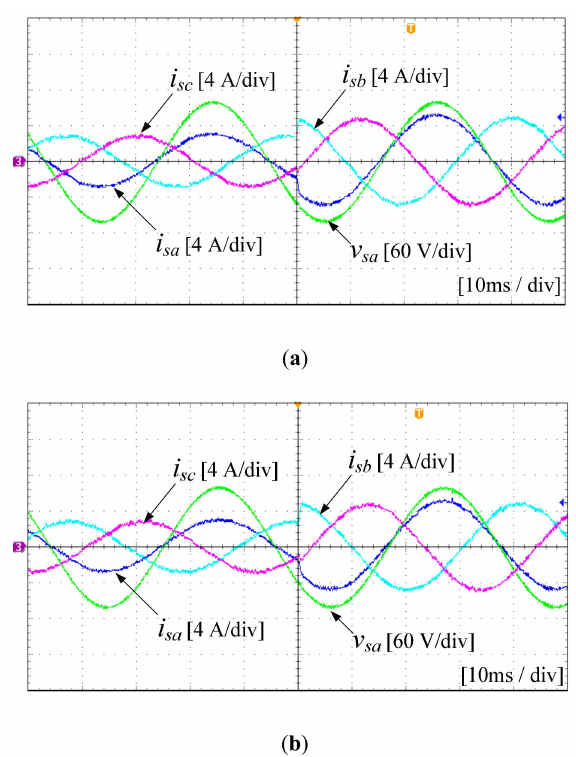
Figure 13. Experimental waveforms of the three-phase source currents and the a -phase source voltage for the source current magnitude step change from 3 A to 5 A obtained from ( a ) the conventional method and ( b ) the proposed